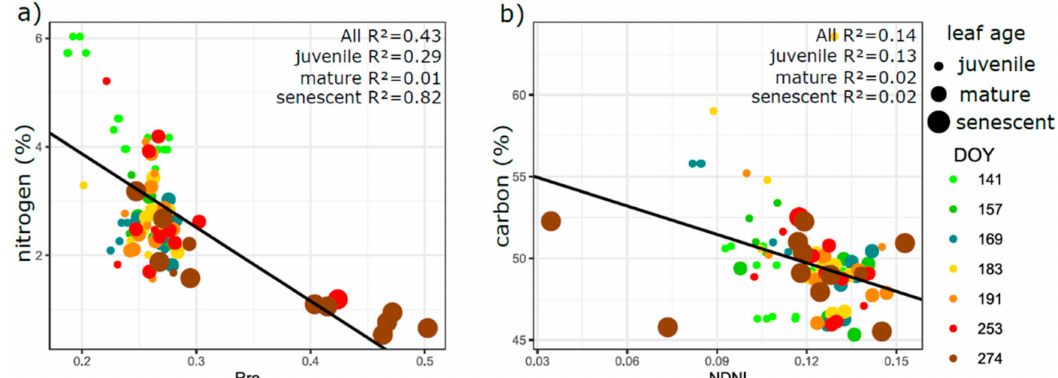
Figure 13. Linear relationship between the best-performing vegetation index and nitrogen or carbon contents. ( a ) Rre index ((R669.8 + R780.6)/2) and nitrogen content (% of dry mass); ( b ) NDNI ((log(1/R1511.9) − log(1/R1681.3))/(log(1/R1511.9) + log(1/R1681.3))) and carbon content (% of dry mass). Different size of circles corresponds to leaf age (juvenile—small, mature—middle, and senescent leaves—large). Different colors correspond to individual DOYs during the season. Coeffi- cient of determination (R 2 ) is shown for all leaf developmental stages pooled together (All); juvenile, mature, and senescent leaves